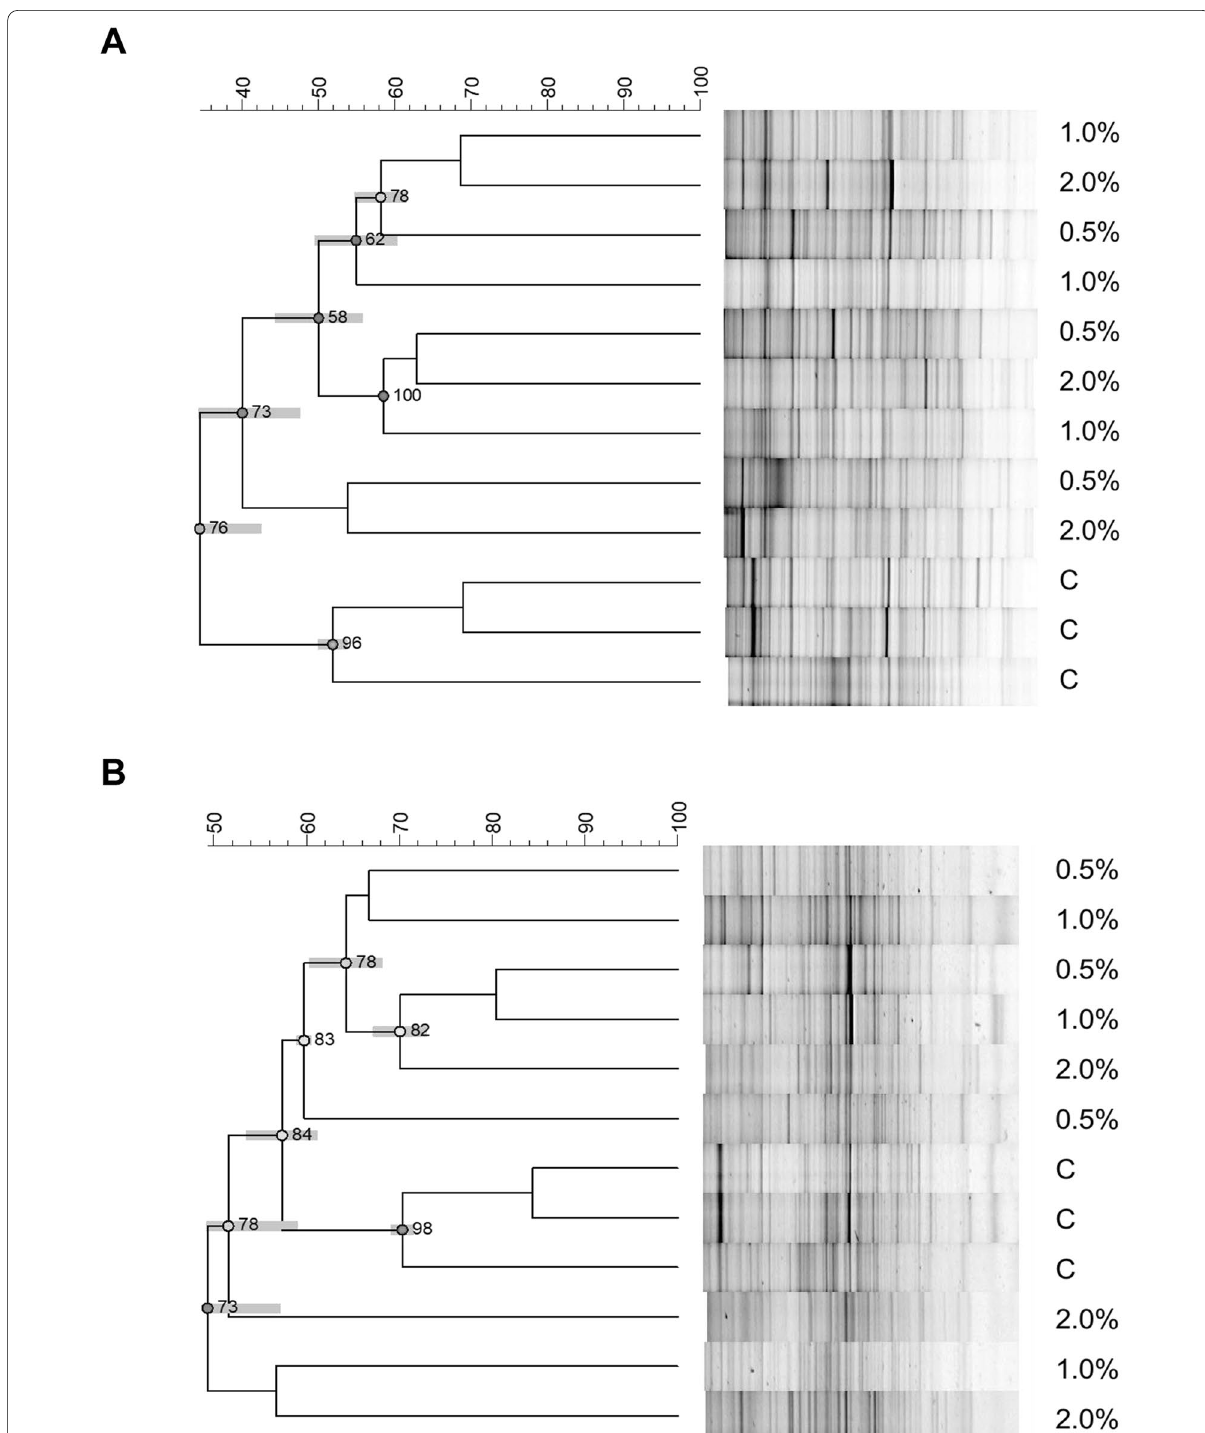
Fig. 2 Cluster analyses of bacterial DGGE profiles. Dendrograms obtained by UPGMA (Unweighted Pair Group Method Using Arithmetic Average) analysis, using Pearson’s coefficient, based on bacterial DGGE profiles obtained from pot-grown olive trees fertilized with two types of sheep wool residues (SWR). A white wool, WW, and B black wool, BW, used at 4 different SWR/soil percentages: 0 (C), 0.5, 1.0, 2.0%. Cophenetic correlation is shown at each node by numbers and coloured dots, ranging between green–yellow–orange–red, according to decreasing values. Standard deviation is shown at each node by a grey